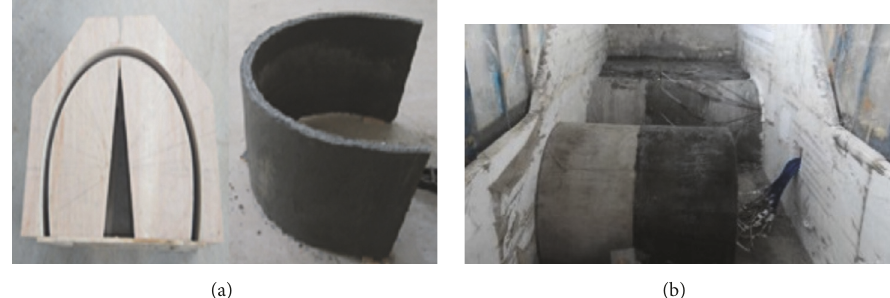
Figure 3: Mold and linings: (a) mold of lining; (b) prefabricated lining [21].